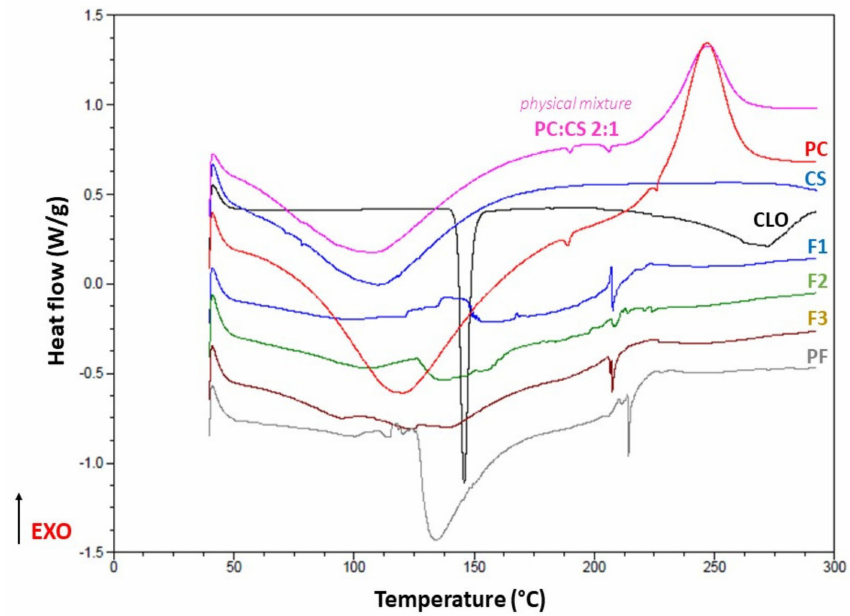
Figure 2. DSC thermograms for PC, CS, CLO, F1–F3, placebo films (PF), and the physical mixture of PC and CS at a weight ratio of